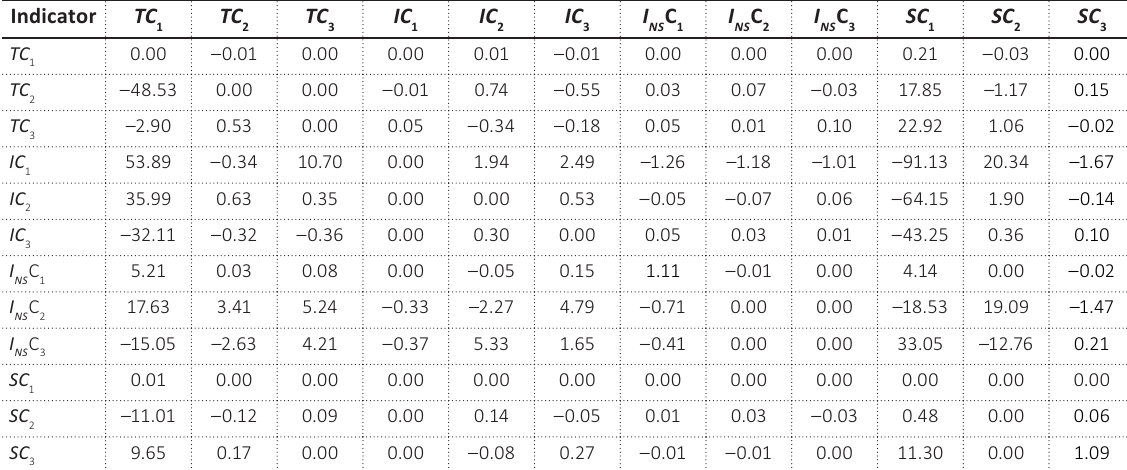
Table 6. Matrix for testing the sensitivity of the quadrocentric model to a change in the factor indicator (a fragment for